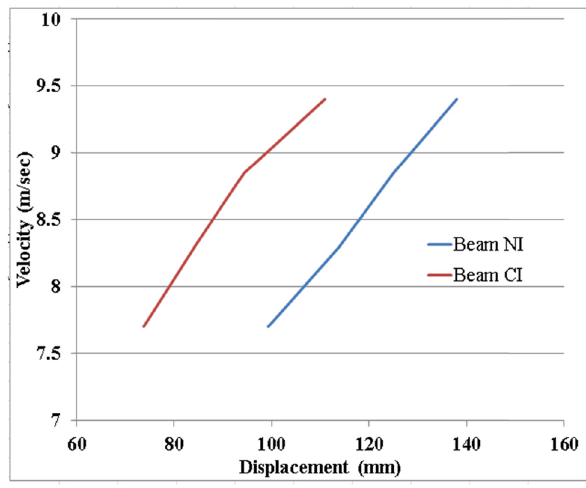
Figure 6: Maximum displacement of the beams NI and CI against the impact velocity.